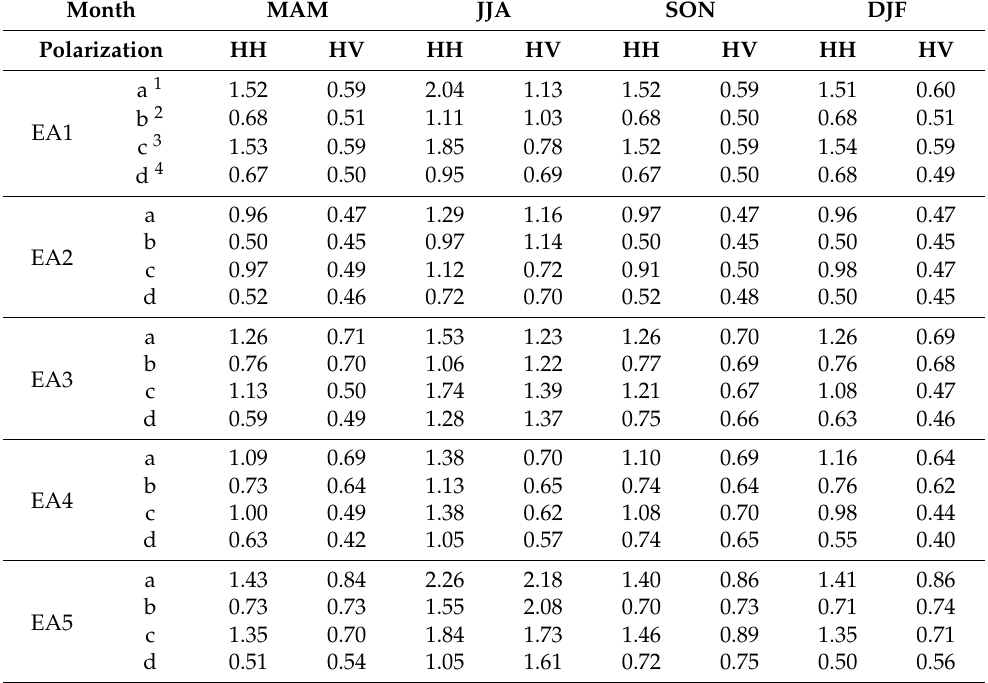
Table 2. RMSE results of the image pairs upon the five EAs